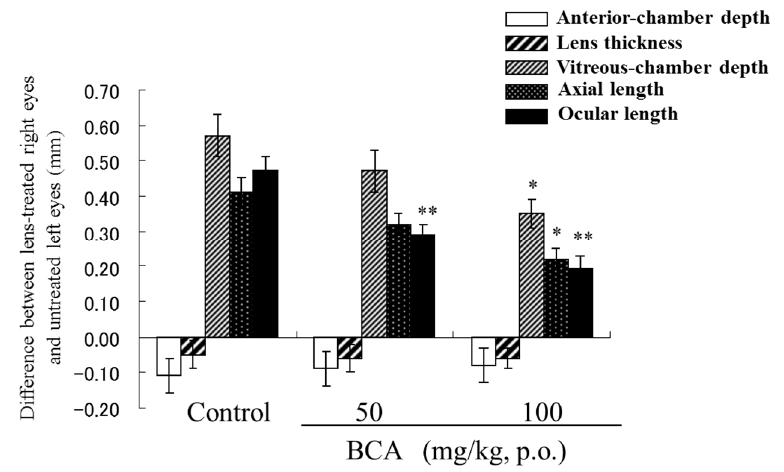
Figure 9. The blackcurrant anthocyanin (BCA) effect on enlargement of each eye component dimensions after application of a negative lens (–8D) in chicks. n = 12, mean ± SEM. paired t -test (intra-group) or Dunnett's multiple comparison test (inter-group). * p < 0.05, and ** p < 0.01; vs. control.